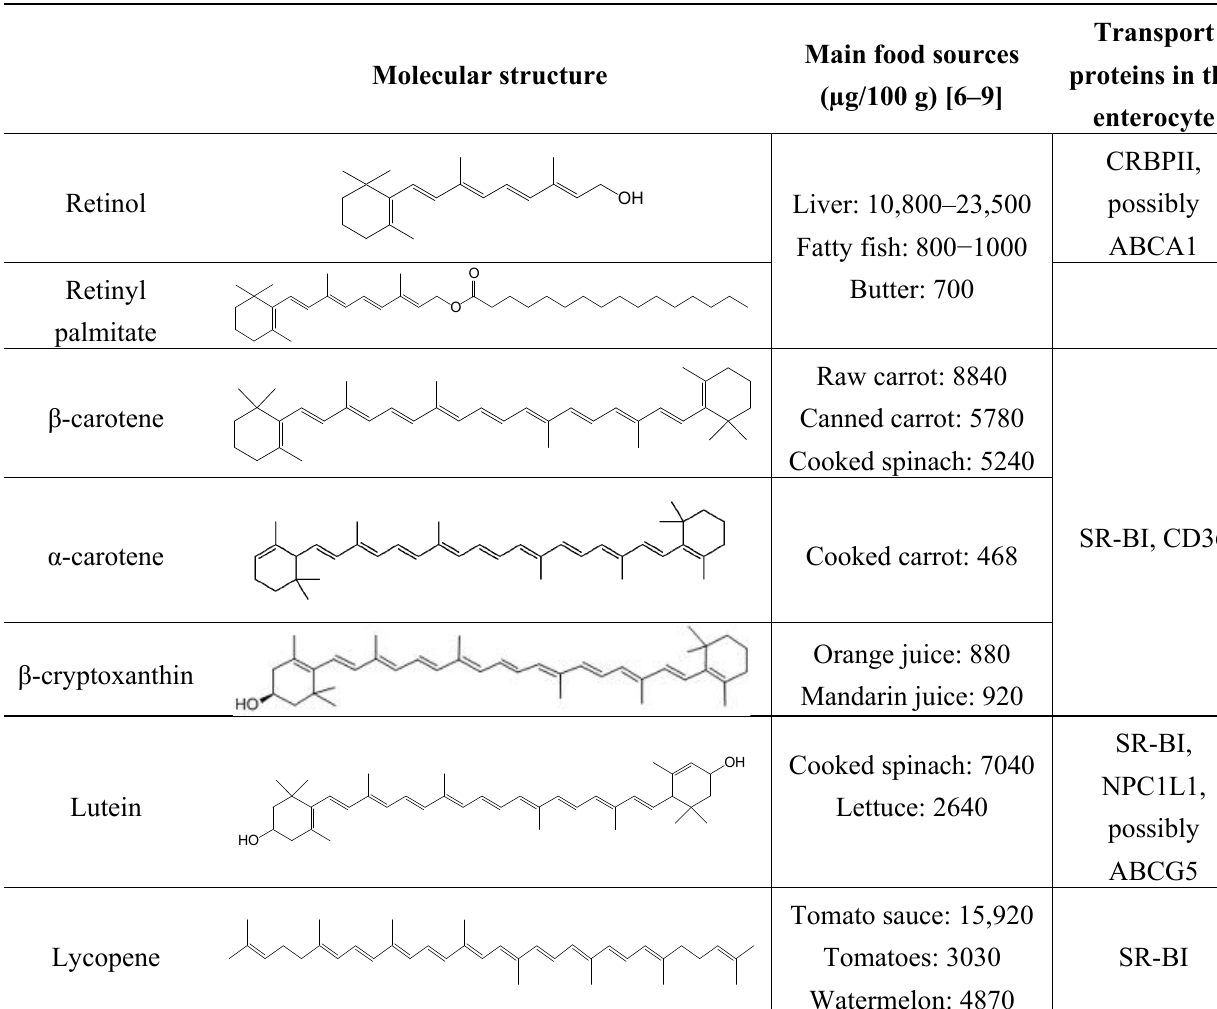
Table 1. Main dietary retinoids and